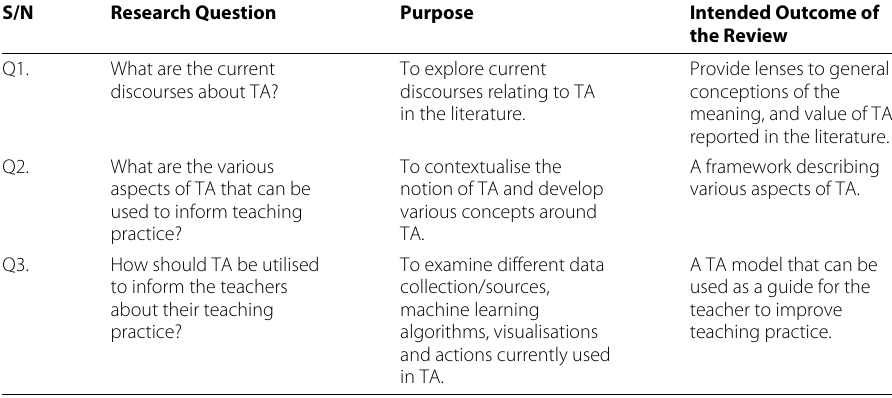
Table 1 Overview of Research Question, Purpose and Outcome S/N Research Question Intended Outcome of